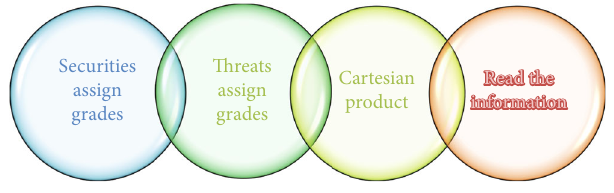
Figure 1: Algorithm of application.